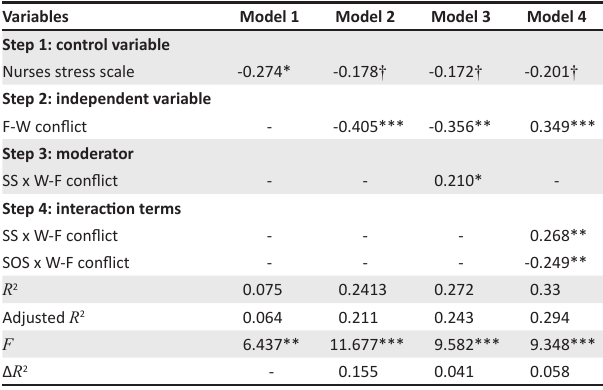
TABLE 2(a): Results of hierarchical regression analyses for the prediction of work satisfaction.